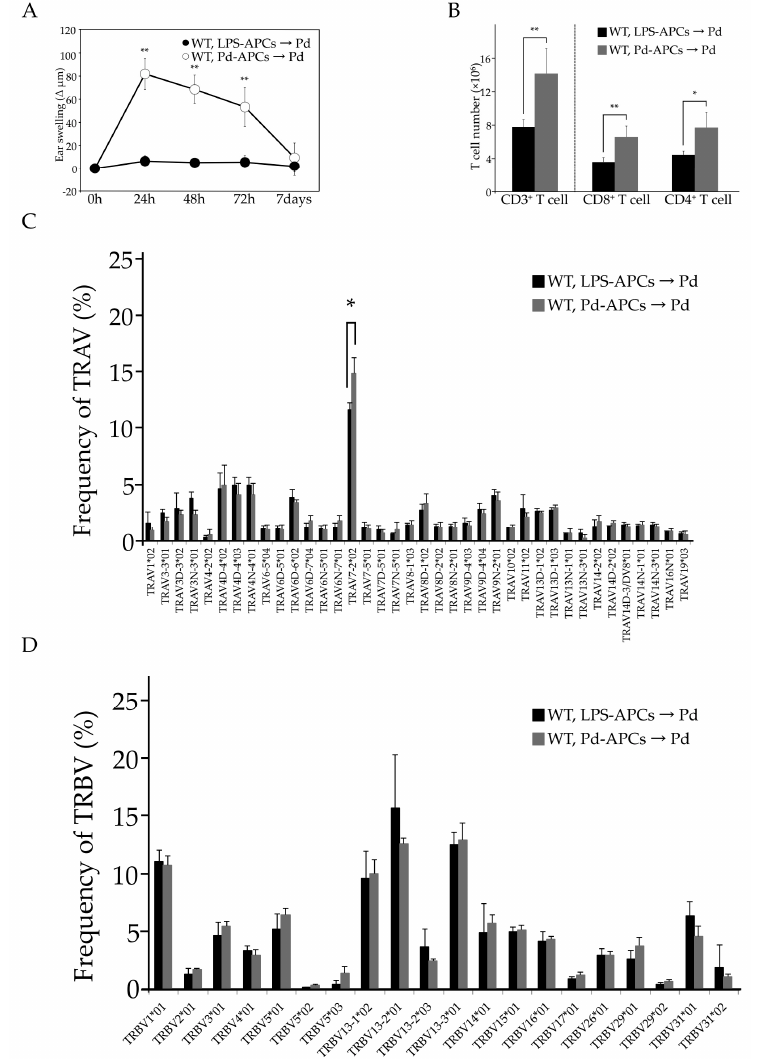
Figure 3. Ear swelling ( A ), number of T cells in each subset ( B ), TRAV ( C ), and TRBV ( D ) repertoires were examined after Pd challenge of mice given WT LPS-APCs or WT Pd-APCs ( n = 4). Values are means ± SD. * p < 0.05 and ** p < 0.01. Similar results of ear swelling ( A ) and T cell numbers ( B ) were obtained in two independent